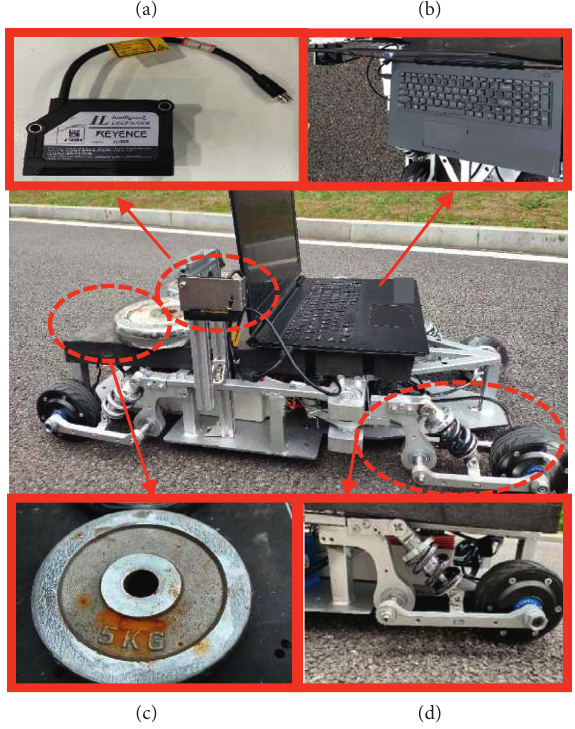
Figure 11: Experimental platform: (a) laser displacement sensor, (b) computer, (c) load, and (d) suspension structure.